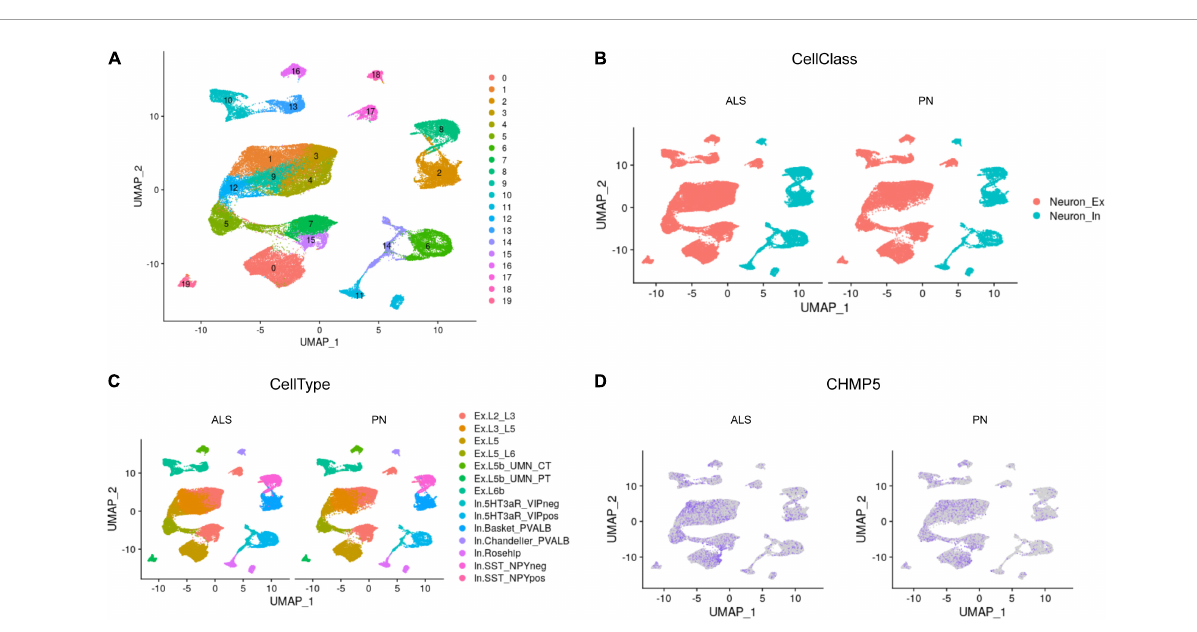
FIGURE6 Single-nucleus RNA-seq analysis. (A) UMAP plot for the analysis of cell subpopulations in the motor cortex neuron, which were divided into 20 cell subsets. (B) The neurons of ALS and PN are classified into excitatory neurons (Neuron_Ex) and inhibitory neurons (Neuron_In), PN: pathologically normal controls. (C) Detailed submap of transcriptional isoforms annotated by motor cortex segment excitatory neurons and inhibitory neurons. (D) The expression analysis of CHMP5 in motor cortex neuron populations of ALS and